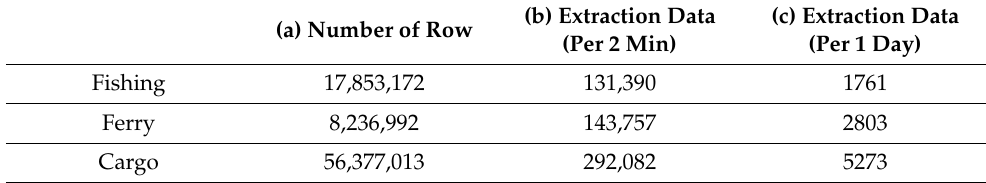
Table 4. Preprocessing of AIS